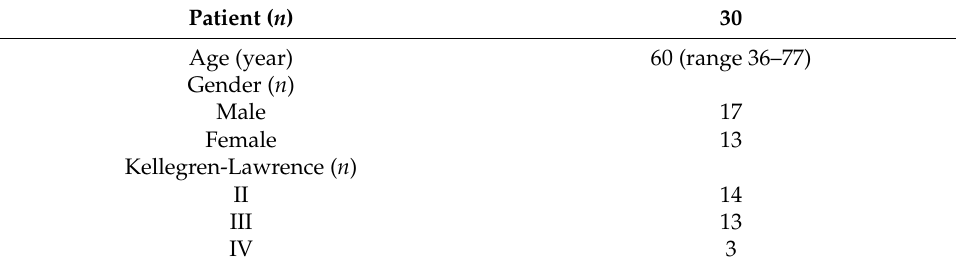
Table 1. Demographic